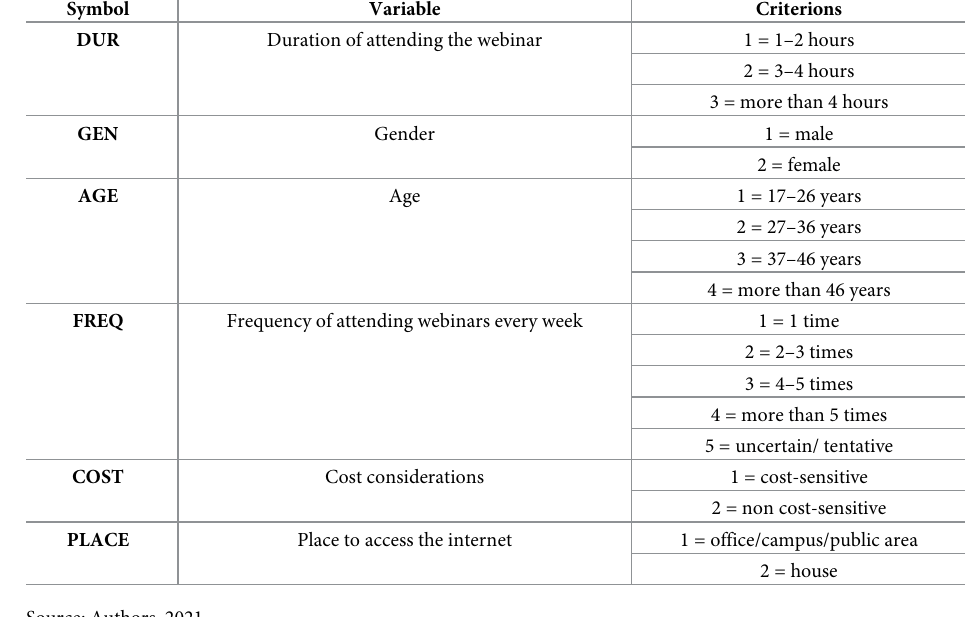
Table 2. The primary data types collected. Symbol Variable